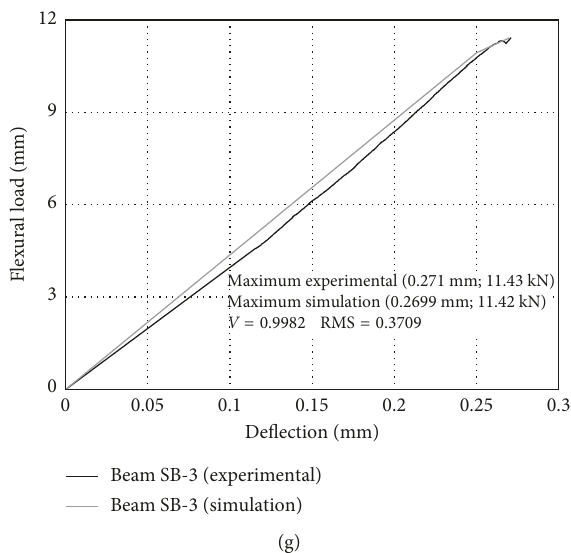
Figure 9: Experimental versus simulation load-deflection curve for series “S.” (a) Beam “S-0” (without fibres). (b) Beam “SP-1” (1% PVA fibres). (c) Beam “SB-1” (1% basalt fibres). (d) Beam “SP-2” (2% PVA fibres). (e) Beam “SB-2” (2% basalt fibres). (f) Beam “SP-3” (3% PVA fibres). (g) Beam “SB-3” (3% basalt